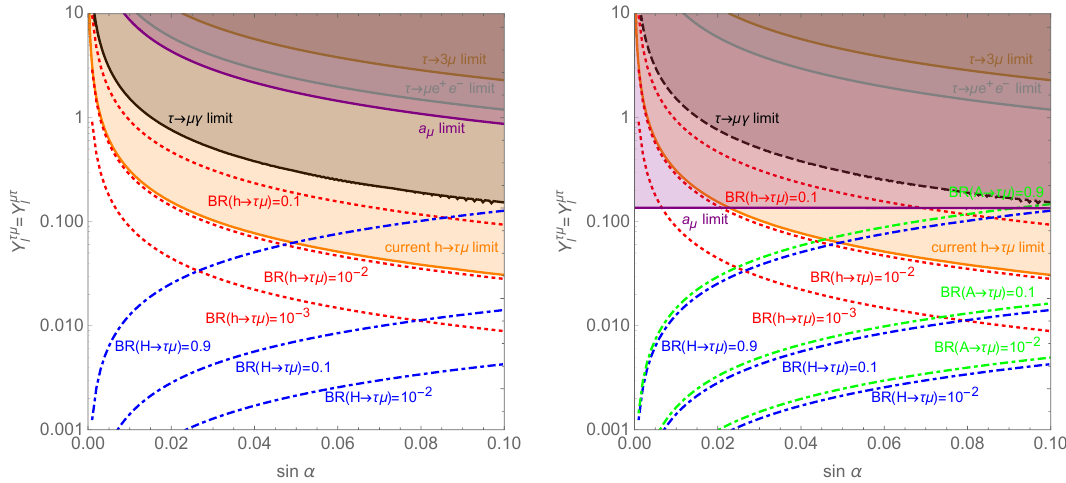
Figure 5. The contours of constant branching ratio for h (cid:28)(cid:22) (dotted red lines) and H (cid:28)(cid:22) ! ! (dashed blue lines). The orange shaded region is excluded by CMS search for h (cid:28)(cid:22) decays. The ! black shaded region is excluded by the (cid:28) (cid:22)(cid:13) search. The purple shaded region is excluded by ! the muon magnetic dipole moment measurement. The gray shaded region and the brown shaded region are excluded by the (cid:28) 3 (cid:22) and (cid:28) (cid:22)e + e (cid:0) search respectively. Note in making these plots ! ! the other Yukawa couplings Y ij are taken to be vanishing and m H = 200 GeV. On the left f